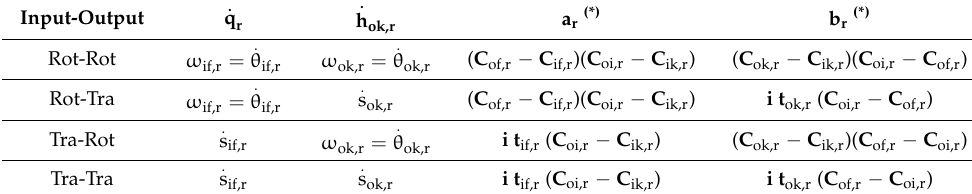
Table 3. Analytic expressions of the coefficients a r and b r appearing in the I/O instantaneous relationship (Equation (8)) of the r-th single-DOF PM ( C mn,r ( t mn,r ) with mn ∈ {if, ok, ik, kf, oi, of} is the complex number that gives the IC position (the unit vector of the positive-translation direction (Figure 3b) of the relative motion of link m with respect to link n in the r-th single-DOF PM). Input-Output . q